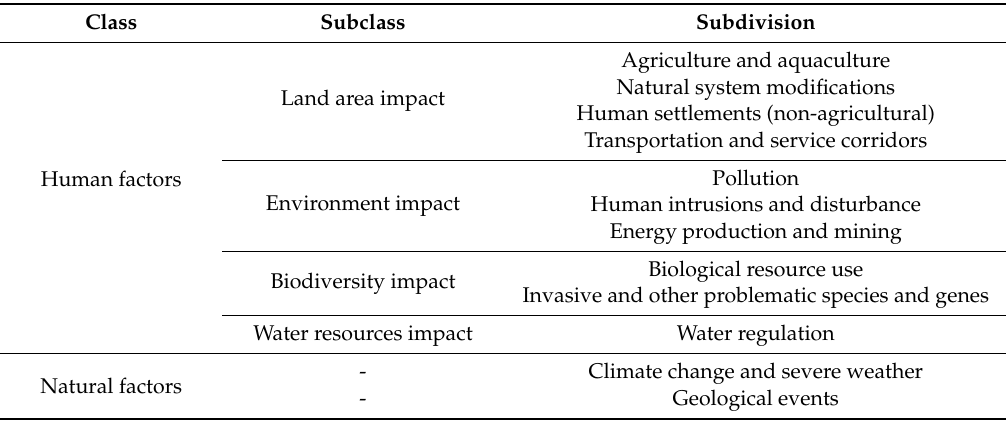
Table 1. Classification of wetland impact